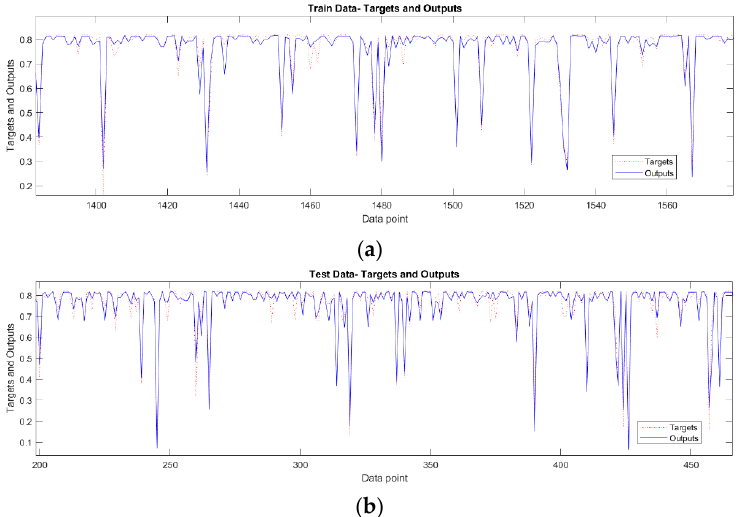
Figure 7. Comparison between real and predicted values of the special interval for ( a ) training dataset, and ( b ) testing dataset.